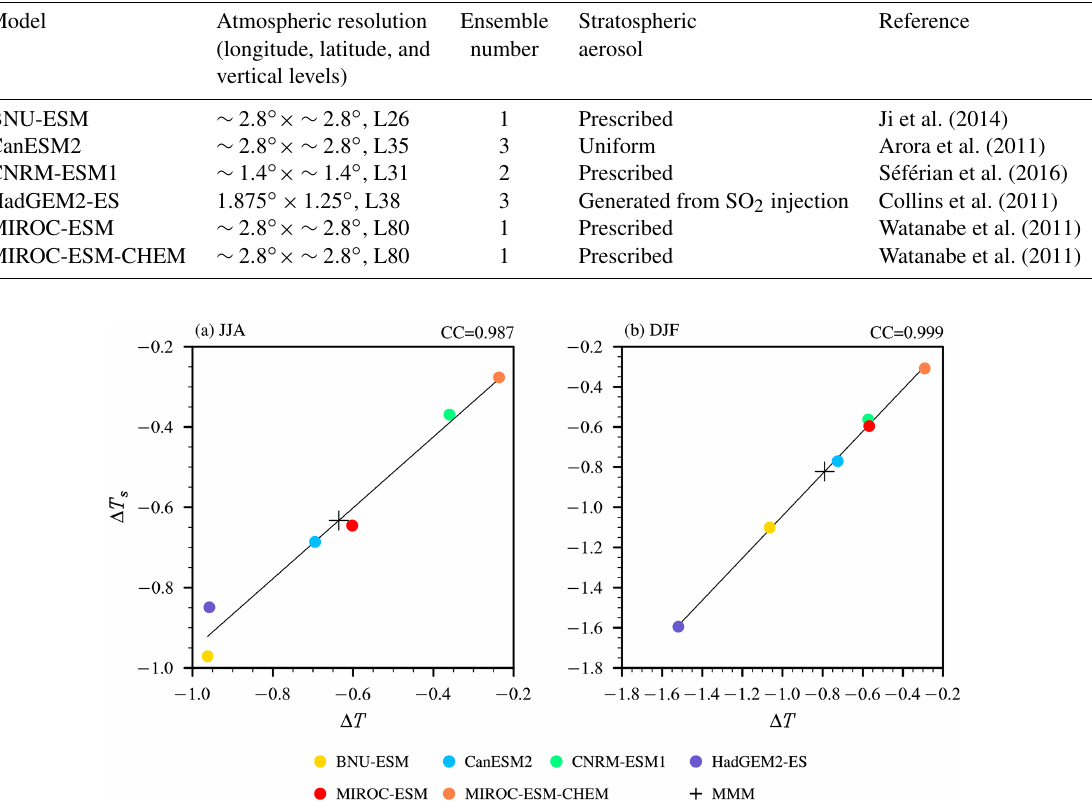
Figure 1. Scatterplots of the relationship between changes in surface air temperature ( T ) and surface temperature ( T s ) over China due to SAI forcing during the period of 2030–2069 in (a) summer (JJA) and (b) winter (DJF), and CC is their correlation coefficient. Scattered dots and crosses represent individual models and their mean,